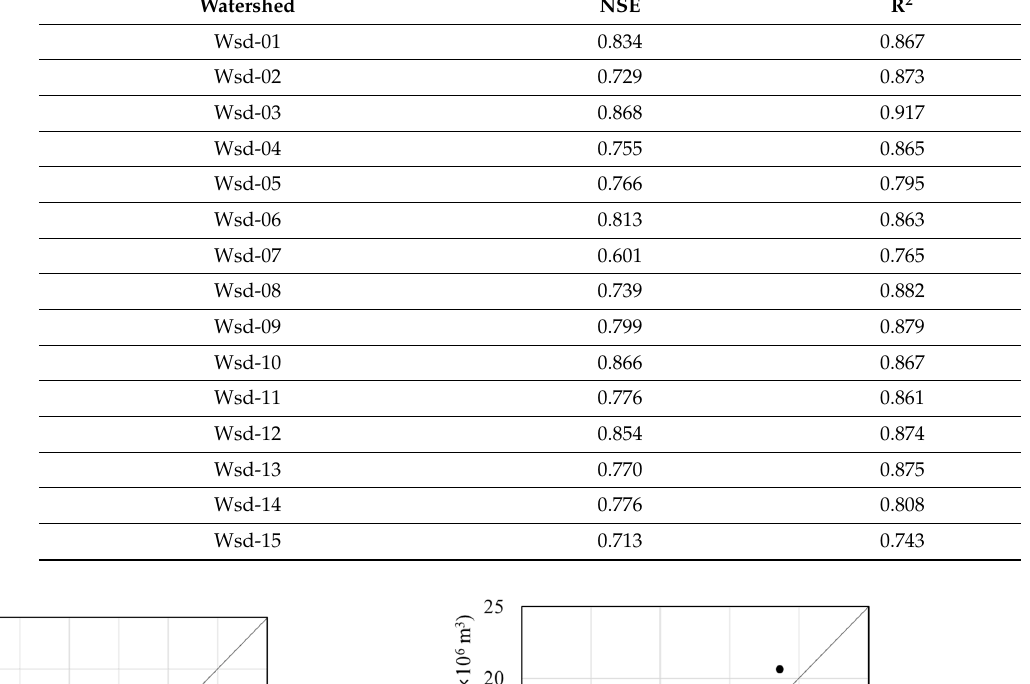
Table 4. NSE and R 2 values of measured and estimated monthly streamflows during calibration.